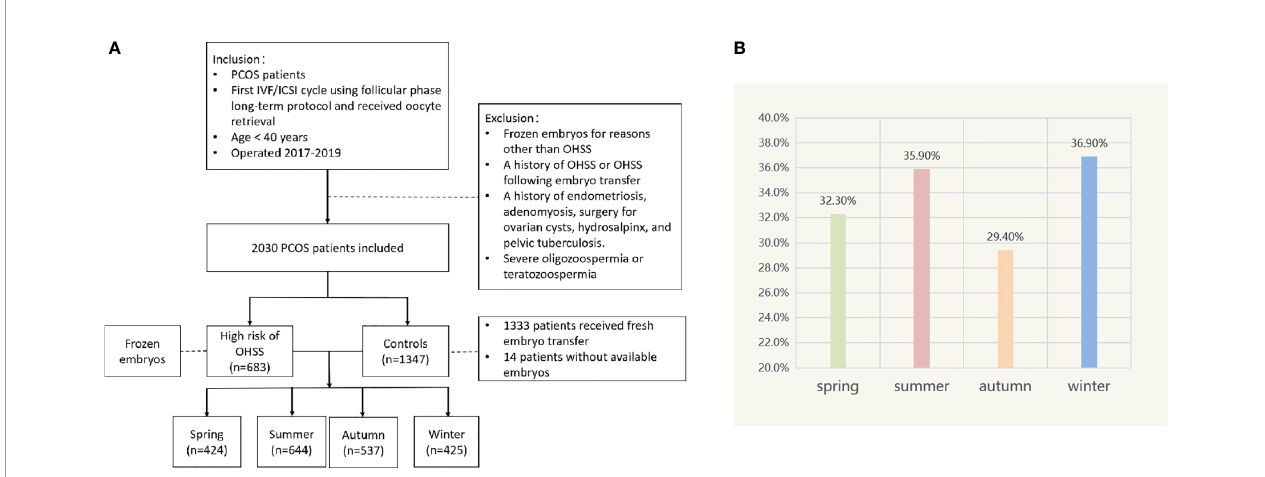
FIGURE 1 | (A) Flow chart depicting the patient selection. (B) Incidence of patients at high risk of OHSS in different seasons.